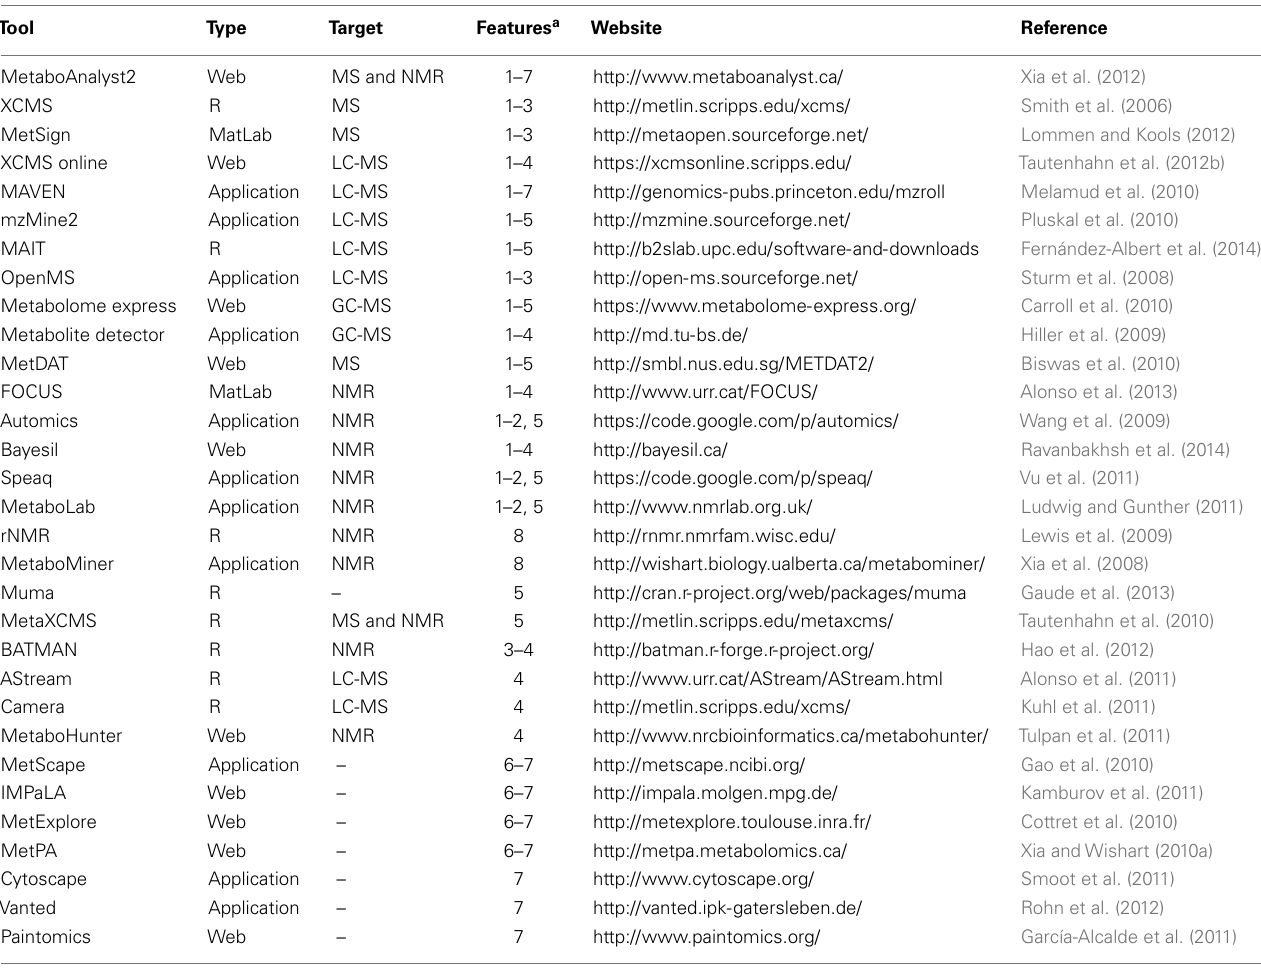
Table 1 | List of tools available for metabolomics spectral processing and data analysis